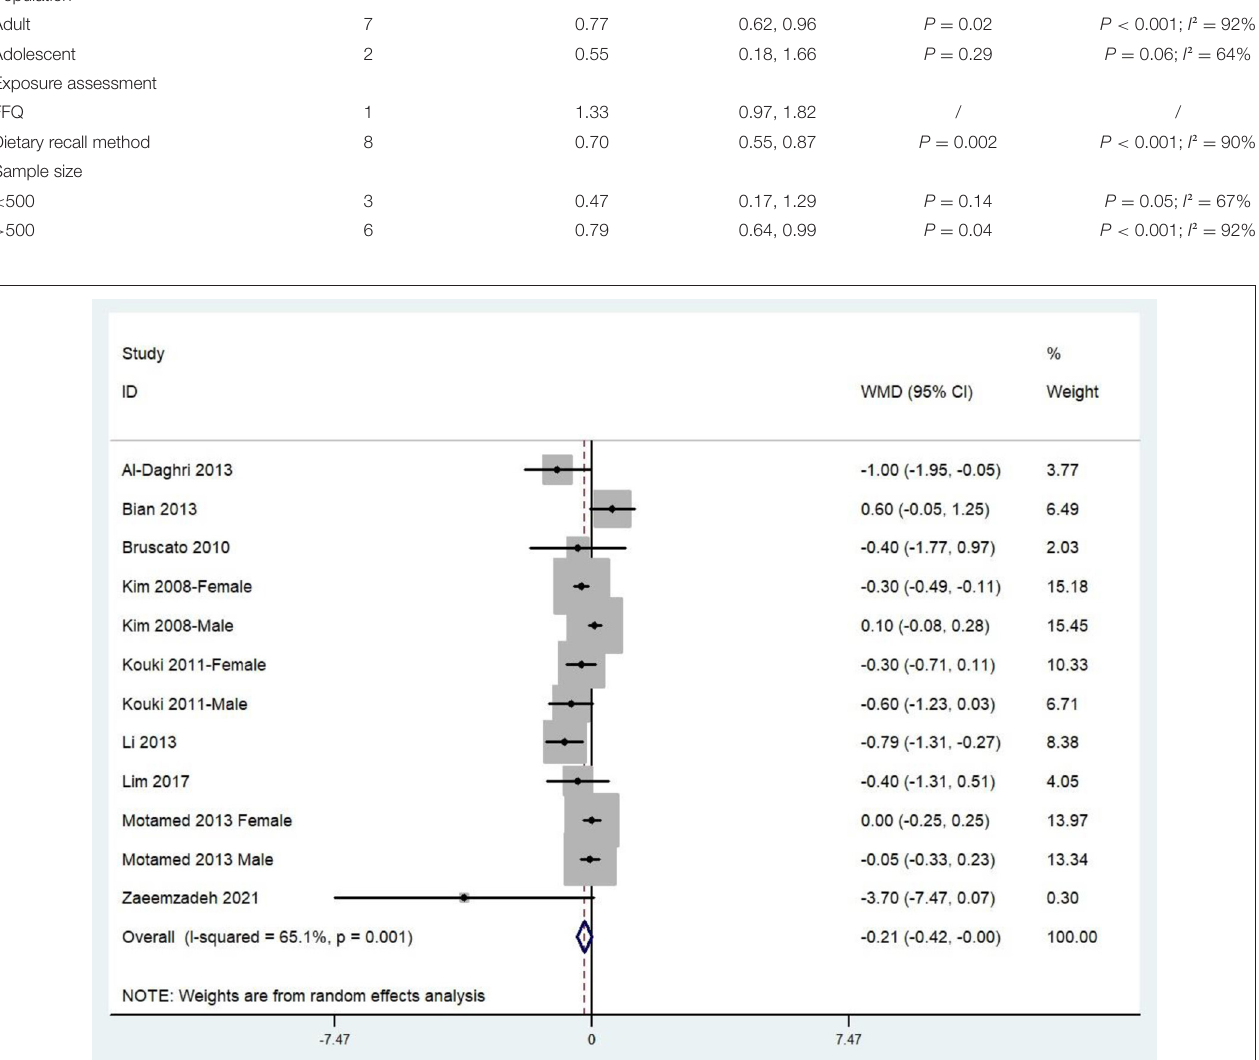
FIGURE 3 | Forest plot of meta-analysis: Weighted mean difference of dietary zinc intake for MetS vs. control subjects.